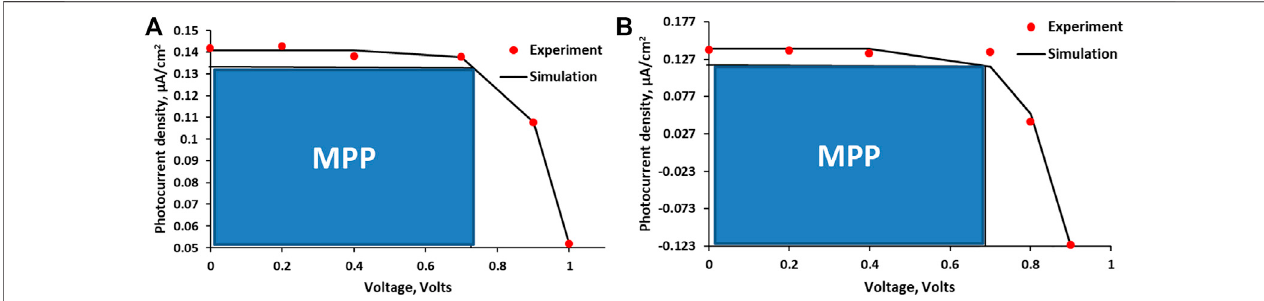
Frontiers in Chemistry |